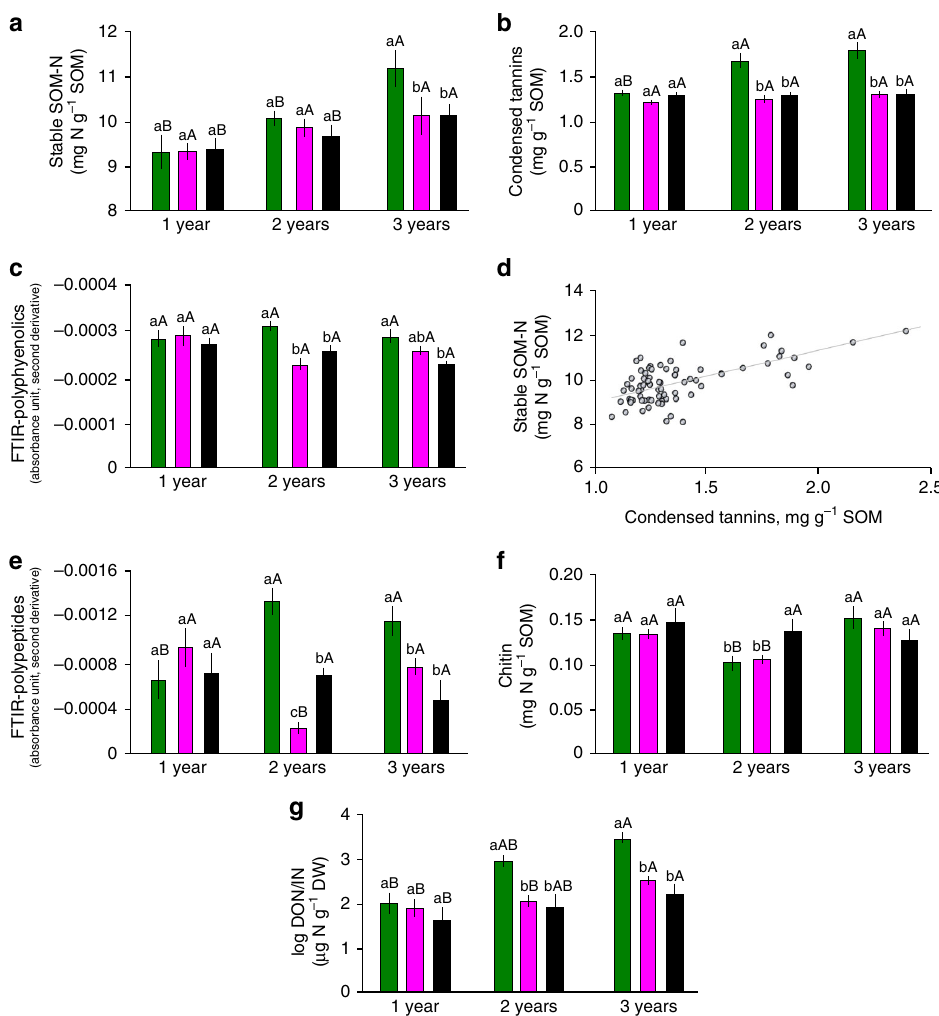
Fig. 3 Soil chemistry and correlations with condensed tannins: a stable SOM-N pool, b condensed tannins, c Fourier-transform infrared (FTIR) polyphenolics (sums of 1512, 1421 and 1388 infrared (IR) bands), d correlation between stable SOM-N vs CT plotted for the whole set of data, e FTIR polypeptides (sums of 1668 and 1543 IR bands) (see Supplementary Figs. 5 and 6), e chitin concentration, f chitin concentration, g dissolved organic N/ inorganic N (DON/IN) ratio (logarithmic values). The different mesh sizes are represented with different colours (from left to right): 1000 µ m (green), 50 µ m (magenta) and 1 µ m (black). The given values are the means of the 24 replicates (except 9 for FTIR and chitin). More results characterizing the soil are given in Supplementary Figs. 3 – 6. Signi fi cant differences ( P < 0.05) between treatments within 1 year are indicated by different letters, and the differences between different years for the same treatment are indicated by capital letters. The error bars represent ±s.e.m. Source data are provided as a Source Data fi